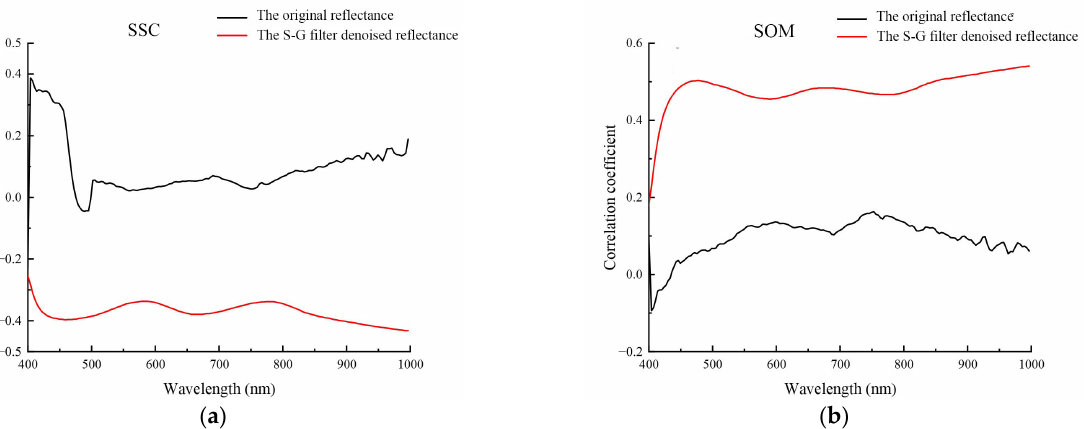
Figure 2. Reflectance of ( a ) original hyperspectral data and ( b ) S–G filter denoised hyperspectral data.